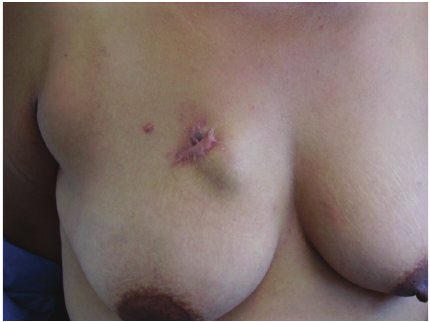
Figure 2: Pale yellow, firm, solid, lobulated, poorly defined mass, of 2.8 cm in length and 2.5 in width, covered by mature adipose tissue.